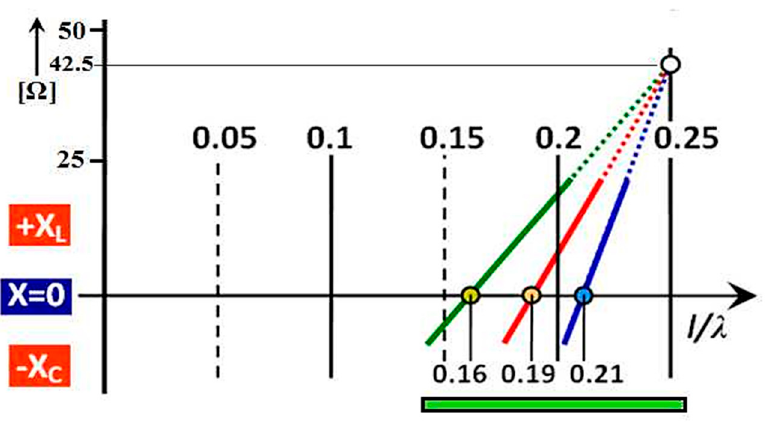
Figure 6. Determining the steepness of the reactance line and the position of the resonant